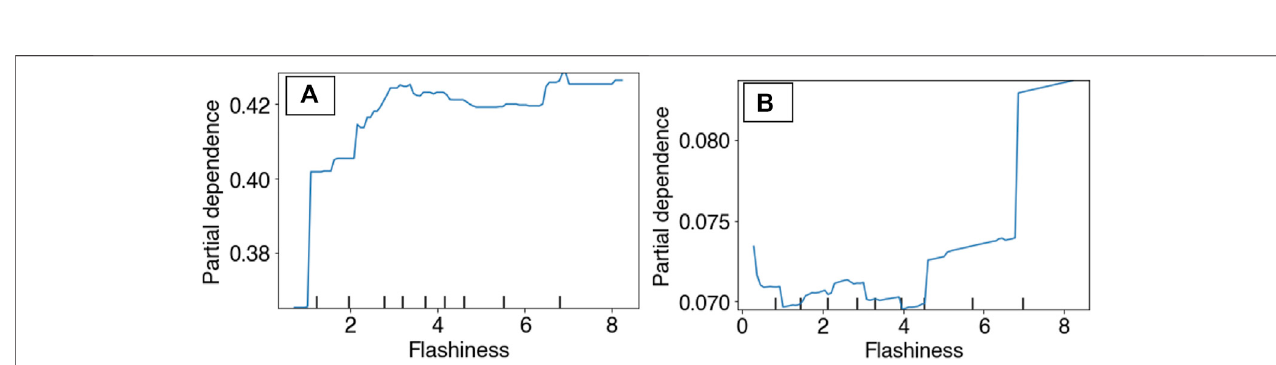
FIGURE 7 | Multivariate Environmental Similarity Surface in the Flathead basin for the 2nd decade (2010 – 2018) vector composite, which was consistent with the fi rst decade (2002 – 2010) composite. Greener shades in the similarity surface indicate that most HUCs fall within a reasonable extrapolation distance from RBT training locations.